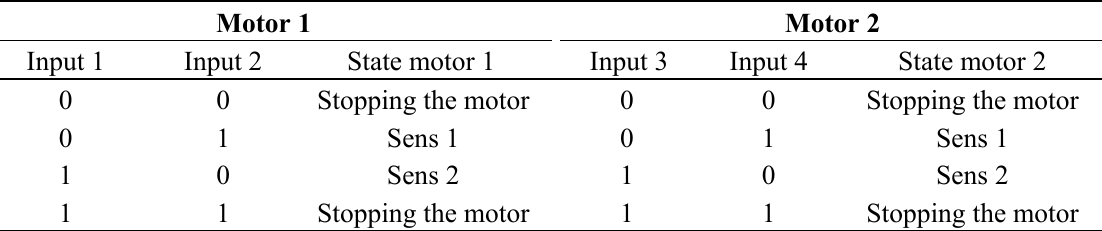
Table 1. Table of different sequences.